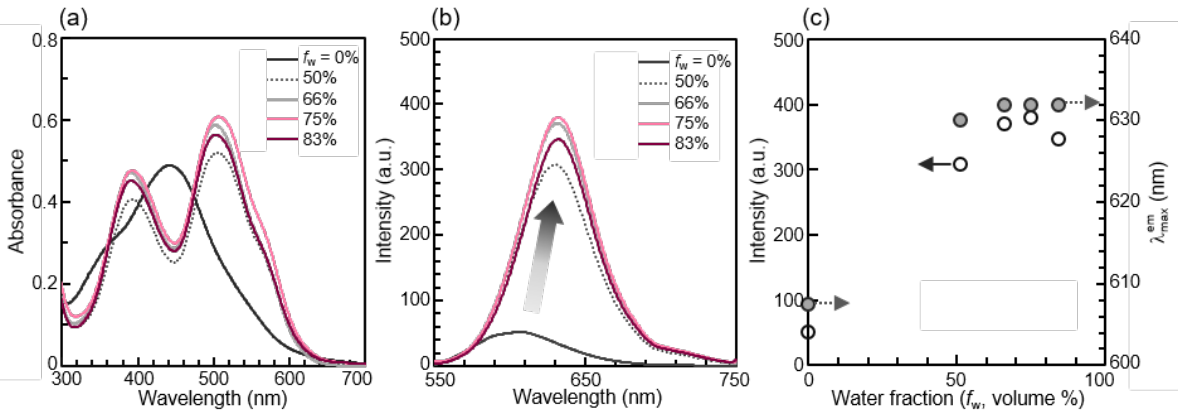
Figure 3. ( a ) Absorption and ( b ) fluorescence ( λ ex = 510 nm) spectra of 3Bu in DMF-H 2 O mixed solutions (10 µ M) prepared by varying the water fraction ( f w ). ( c ) Changes in the fluorescence intensity at the maximum fluorescence wavelength as a function of f w